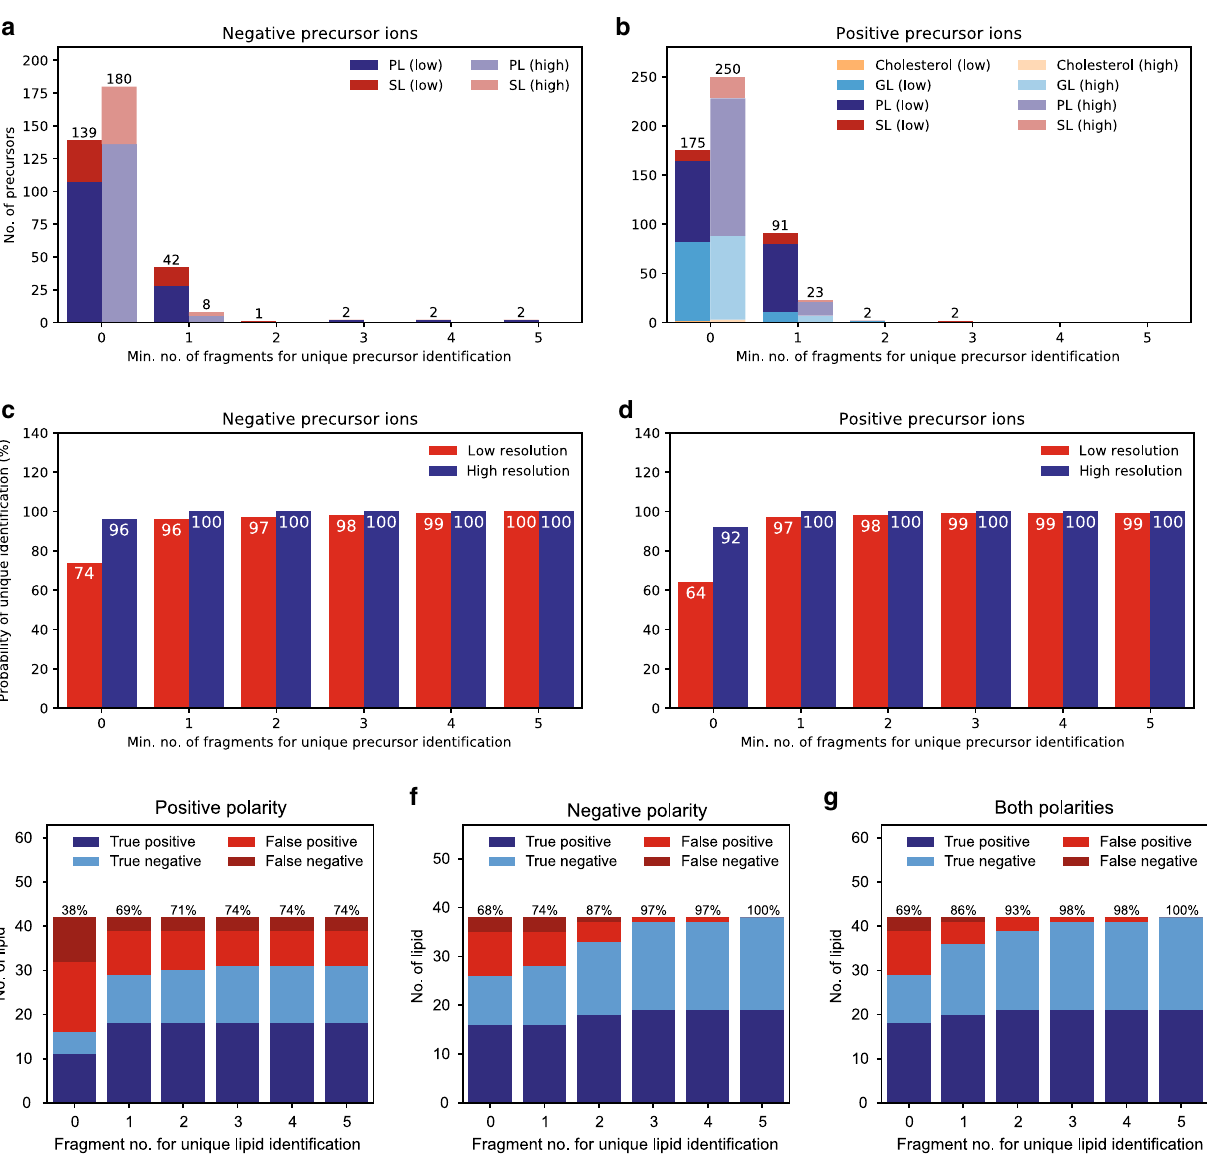
Fig. 5 Probability and false match analysis proves LipidCreator output as correct. For probability calculations, the yeast lipidome 34 , a set of target lipids and a set of decoy lipids (in total: 188 negative/273 positive lipid ions) were chosen. a , b The minimum number of lipid ions that can be unambiguously identi fi ed using 0 fragments (i.e., precursor mass), 1 arbitrary fragment etc. was calculated in negative and positive ion mode, respectively. The MS and MS/MS mass tolerance was set to ±0.5 Da (representing low resolution instrumentation) or ±2.5 ppm (representing high resolution instrumentation). Sphingolipids (SL) and glycerophospholipids (PL) were investigated in both polarities while, glycerolipids (GL) and sterol lipids (ST) were investigated in positive ion mode only. c , d Cumulative probability to unambiguously identify any lipid ion when using 0 fragments, 1 arbitrary fragment etc. using 0.5 Da (low) or 2.5 ppm (high) tolerance in positive and negative ion mode, respectively. To verify the calculations, LC/ESI MS/MS experiments were conducted in a yeast lipidome background. The monitored lipid set contained yeast lipids, 21 target lipids, and 21 decoy lipids. Here, (un)identi fi ed target lipids are referred to as true positives or false negatives, whereas (un)identi fi ed decoys are denoted as false positives or true negatives, respectively. The identi fi cation is based on the upper number of used fragments, where 0 fragments means the identi fi cation is solely based on precursor mass. The accuracy ratio (%) is plotted above each bar. e Numbers of identi fi ed and unidenti fi ed lipids when considering only positive precursor ions (note that the majority of lipids do not contain more than one fragment in positive mode). Our knowledge base contains only one or two positive fragments for some lipids, therefore the percentage remains unchanged when choosing more fragments. f Numbers of identi fi ed and unidenti fi ed lipids in negative mode. g Total number of identi fi ed and unidenti fi ed lipids when taking both polarities into account. When considering three fragments, all target lipids could be identi fi ed and only one decoy was positively identi fi ed. Measurements were carried out on a pooled sample of fi ve individual extraction experiments and were conducted in technical triplicates ( n = 3 independent experimental replicates). Source data are provided as a Source Data fi